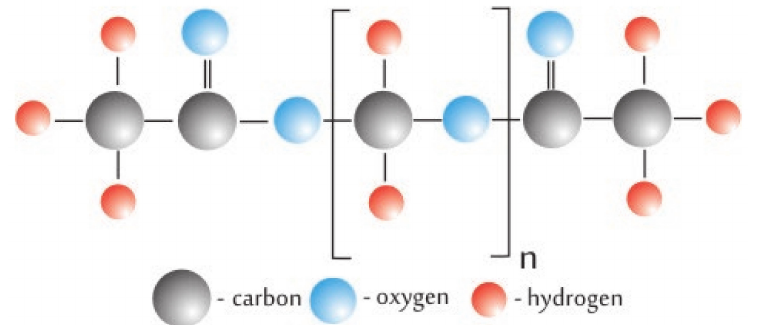
Figure 1. POM polymer model idealized molecule